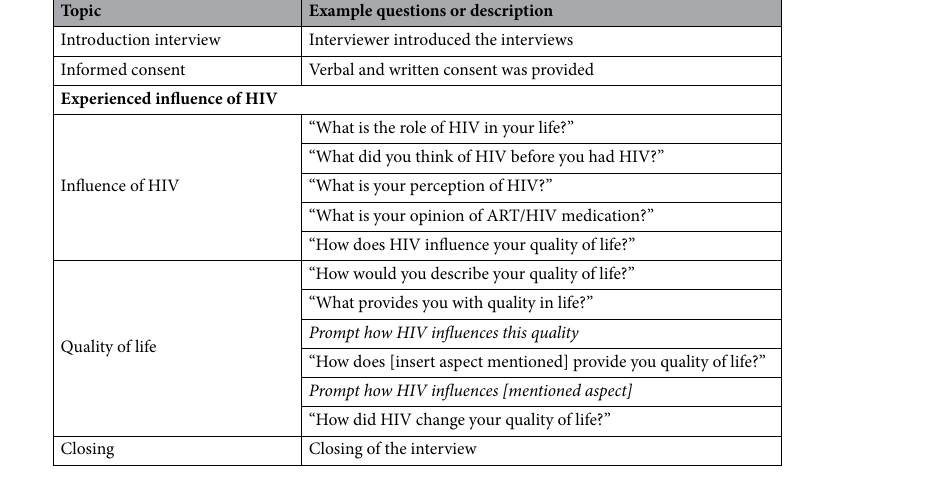
Table 1. Interview topic guide for PHIV and key